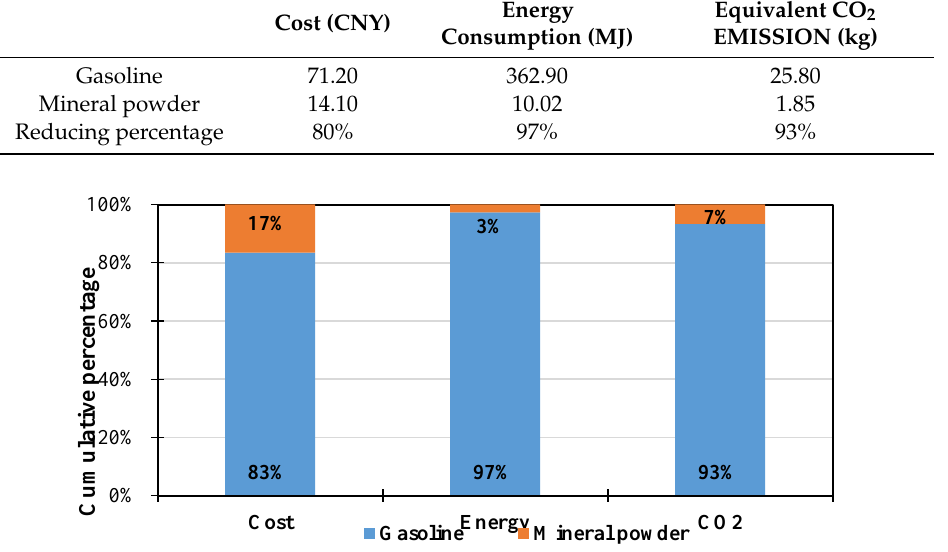
Figure 6. Cumulative percentage distribution for the investigated approaches according to cost and environmental impacts.